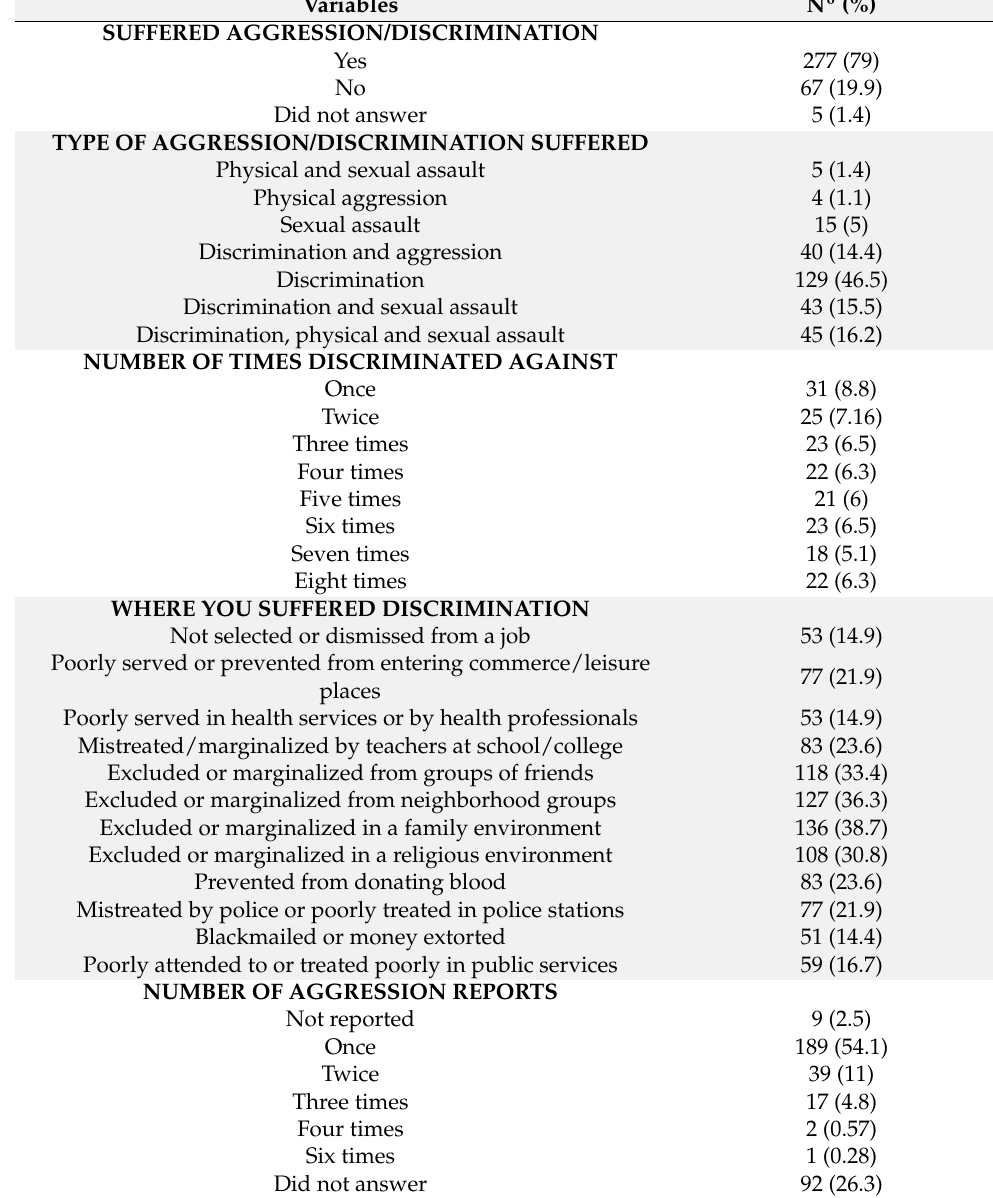
Table 2. Characteristics related to aggression/discrimination suffered by men who have sex with men in Bel é m, Par á , Brazil,